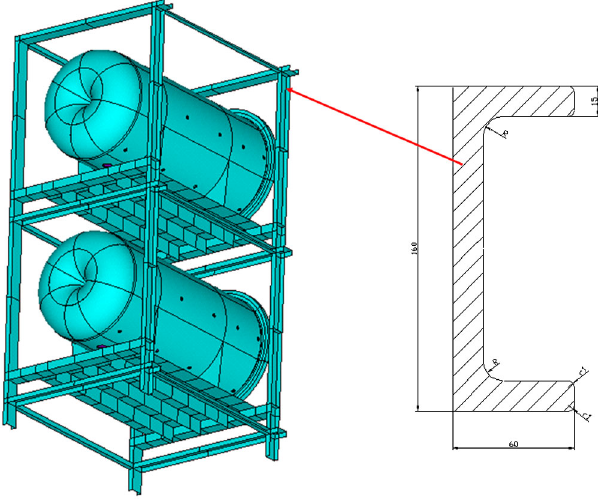
FIG. 25. A symmetric half of the four-horn assembly with detail of the channel section used for the supporting frame.